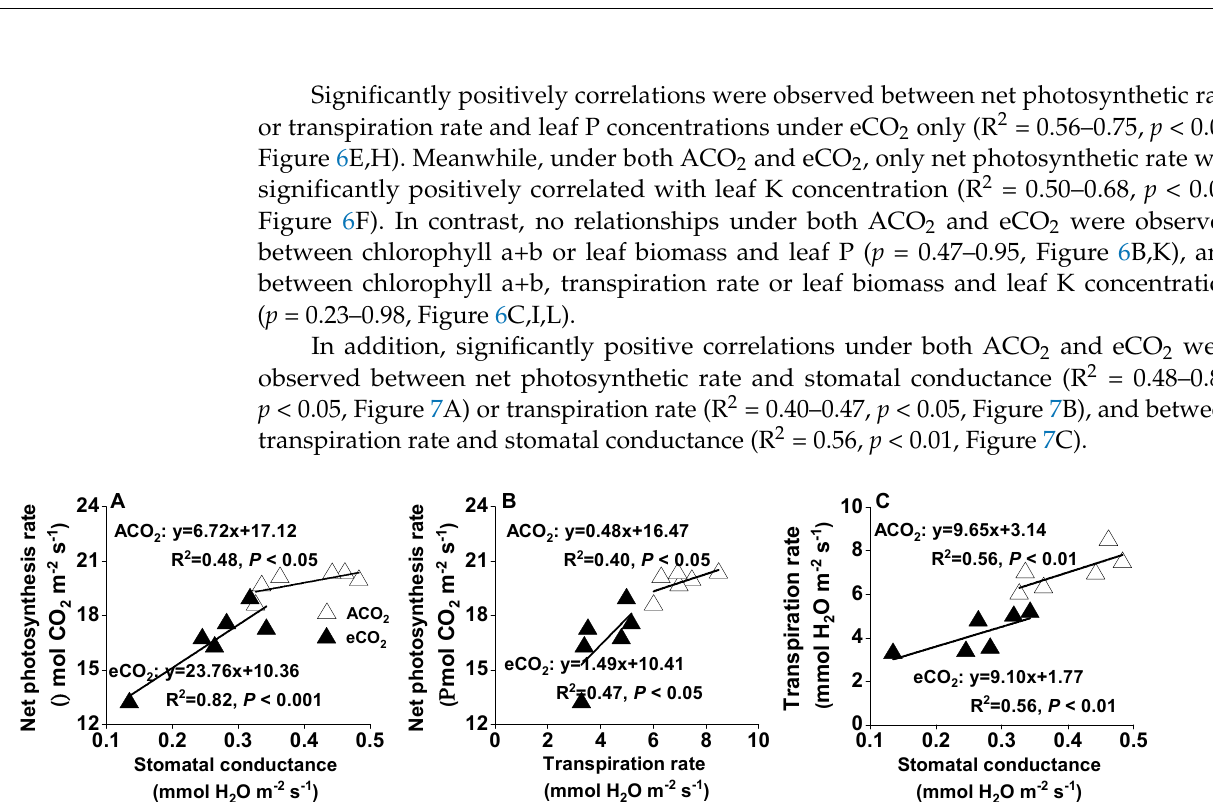
Figure 7. Relationships between net photosynthetic rate and stomatal conductance ( A ), and transpiration rate ( B ); transpiration rate and stomatal conductance ( C ).Linear regressions were fitted to data for two mulberry varieties ( Morus multicaulis Perr. var. QiangSang and NongSang) grown under ambient CO 2 (ACO 2 , 410/460 ppm, daytime/nighttime) and elevated CO 2 (eCO 2 , 710/760 ppm) levels. Open triangles and closed triangles represent data under ACO 2 and eCO 2 , respectively.